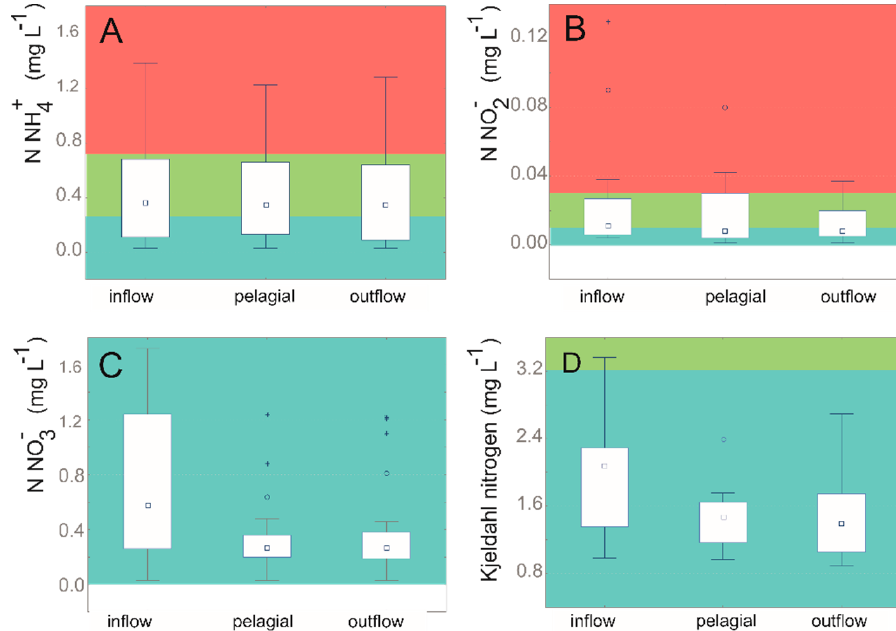
Figure 6. Nitrogen speciation in the Paprocany reservoir water on the inflow, pelagial, and outflow water: ( A ) N-NH 4 + ; ( B ) N-NO 2 − ; ( C ) N-NO 3 − ; ( D ) Kjeldahl nitrogen. Point—median; box—first and third quartile; range—min and max values; asterisk—extreme values. Color in the picture shows the water purity class: blue—class I; green —class II; red—out-of-class water.